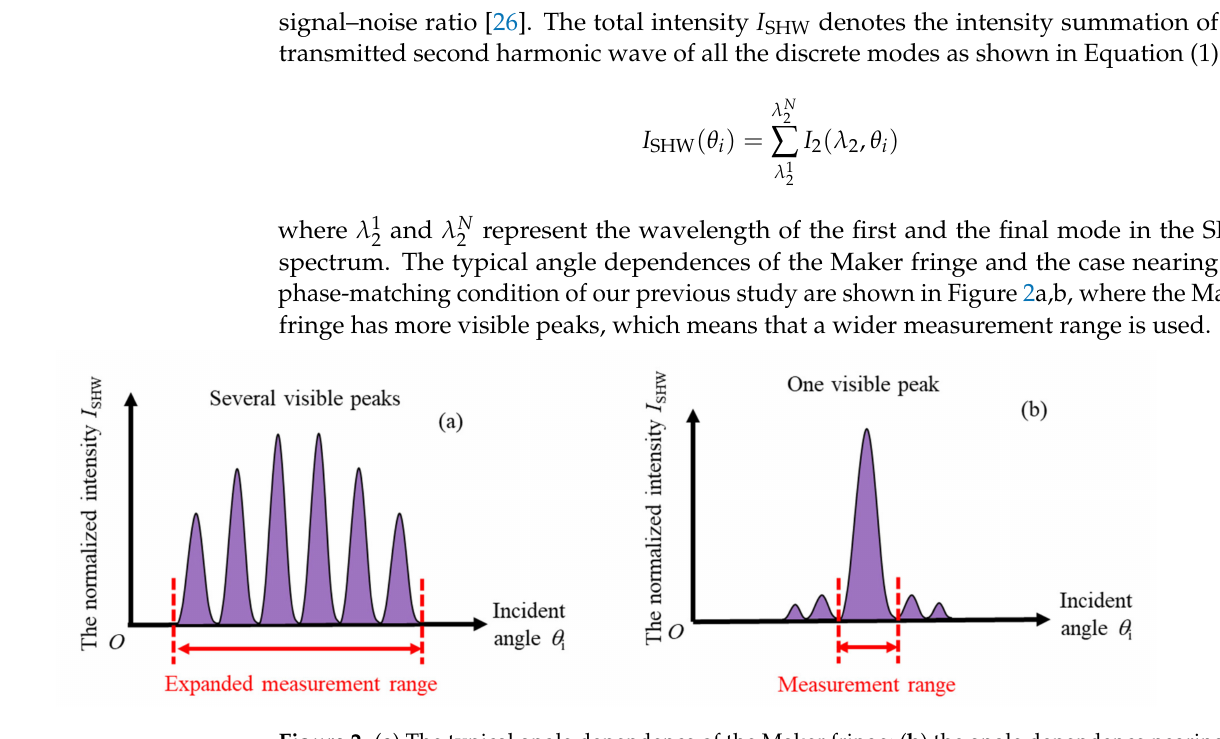
Figure 2. ( a ) The typical angle dependence of the Maker fringe; ( b ) the angle dependence nearing the phase-matching condition.